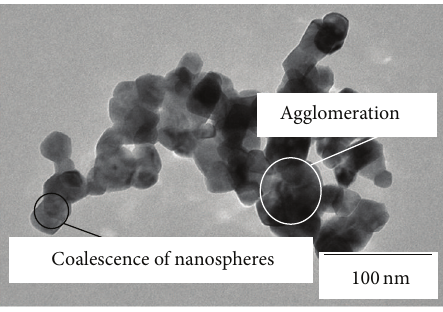
Figure 4: XRD patterns of HA with the addition of 0.5 wt% 3YSZ under two different sintering atmospheres at 1250 ∘